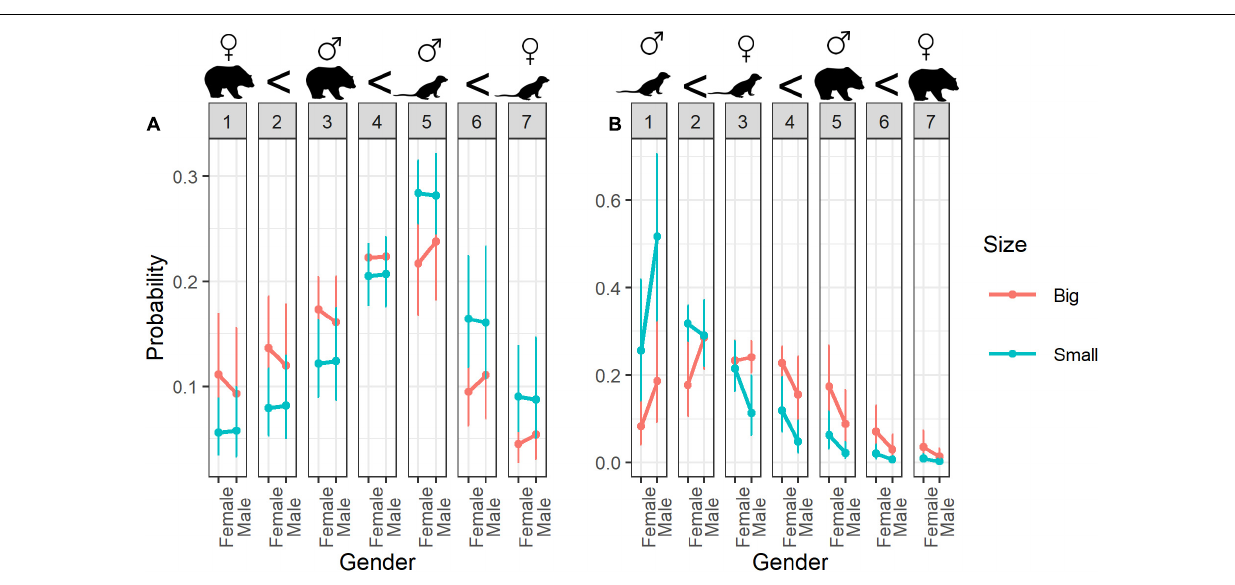
Gender was not statistically significant for willingness to protection as an individual factor nor for